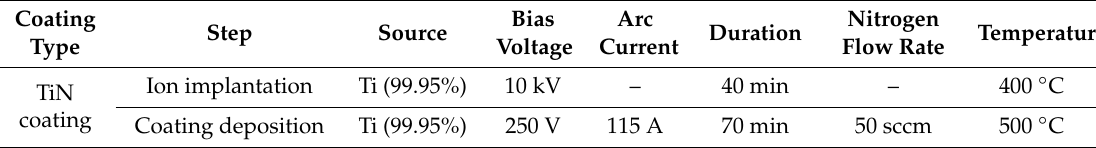
Table 1. Deposition parameters of coating thickness uniformity examination.